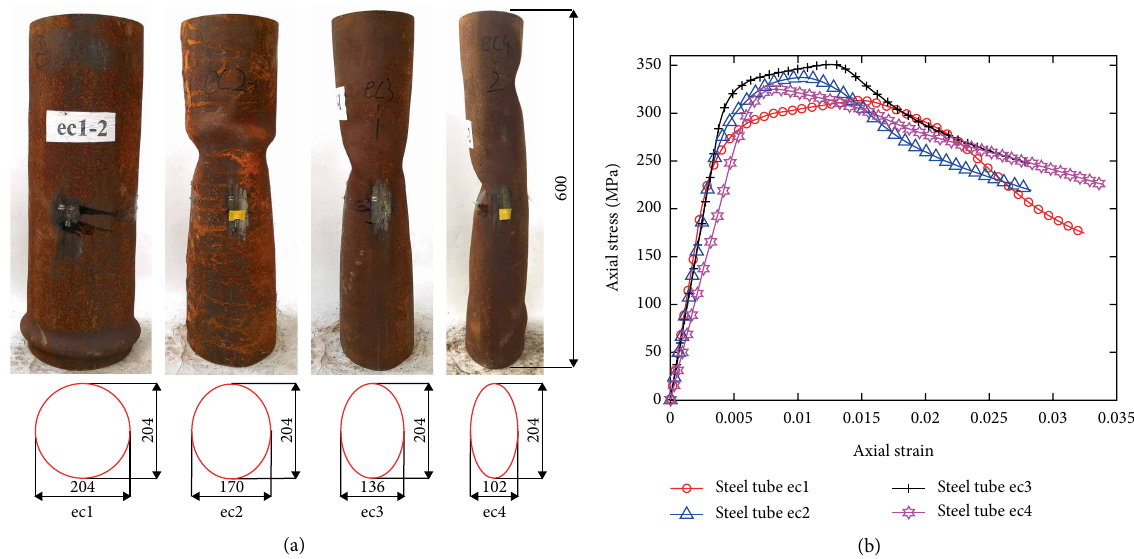
Figure 5: Axial compression test of elliptical hollow steel tubes. (a) Elliptical hollow steel tubes. (b) Axial stress–strain curves.